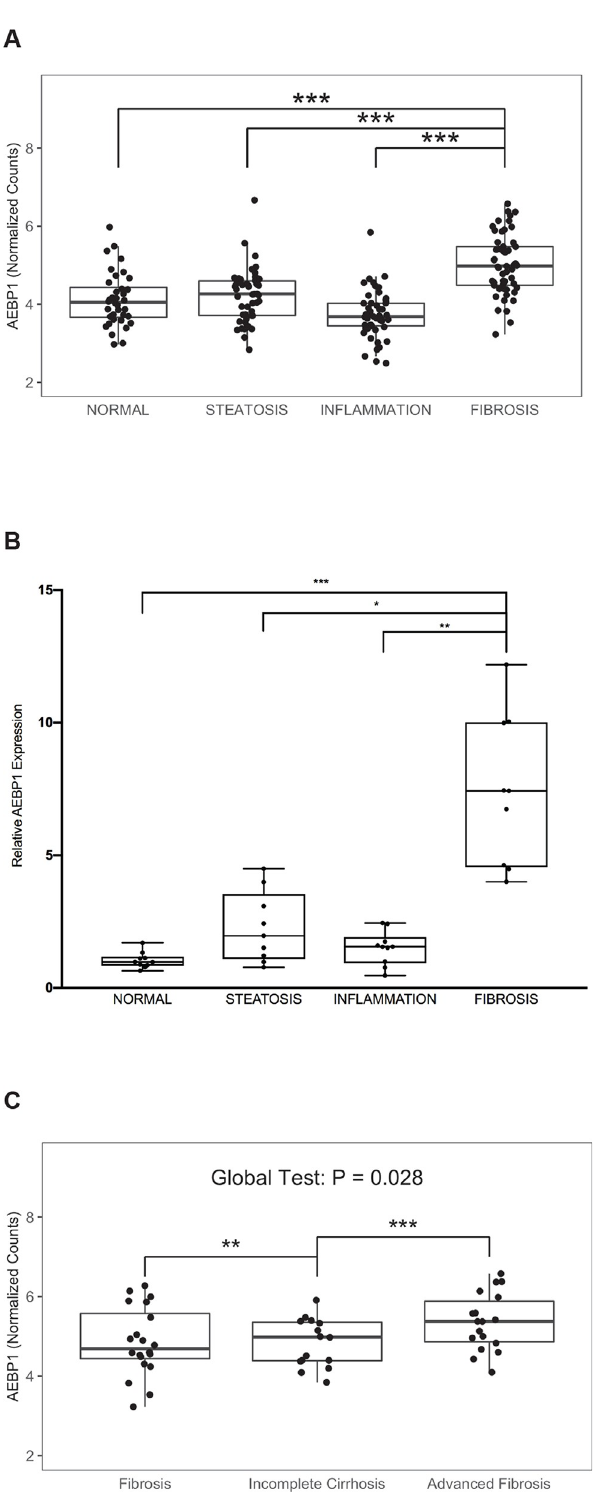
Fig 1. Hepatic AEBP1 expression in NAFLD patients. A) Using RNA-sequencing data [9], we determined average AEBP1 transcript abundance (normalized counts) in NAFLD samples across a spectrum of liver histology (36 normal, 50 steatosis, 52 inflammation, and 53 fibrosis). The ordinal logistic regression showed a significant positive trend ( β = 0.244; P = 4.8E-4), whereas the pairwise comparisons conducted with logistic regression showed a significant